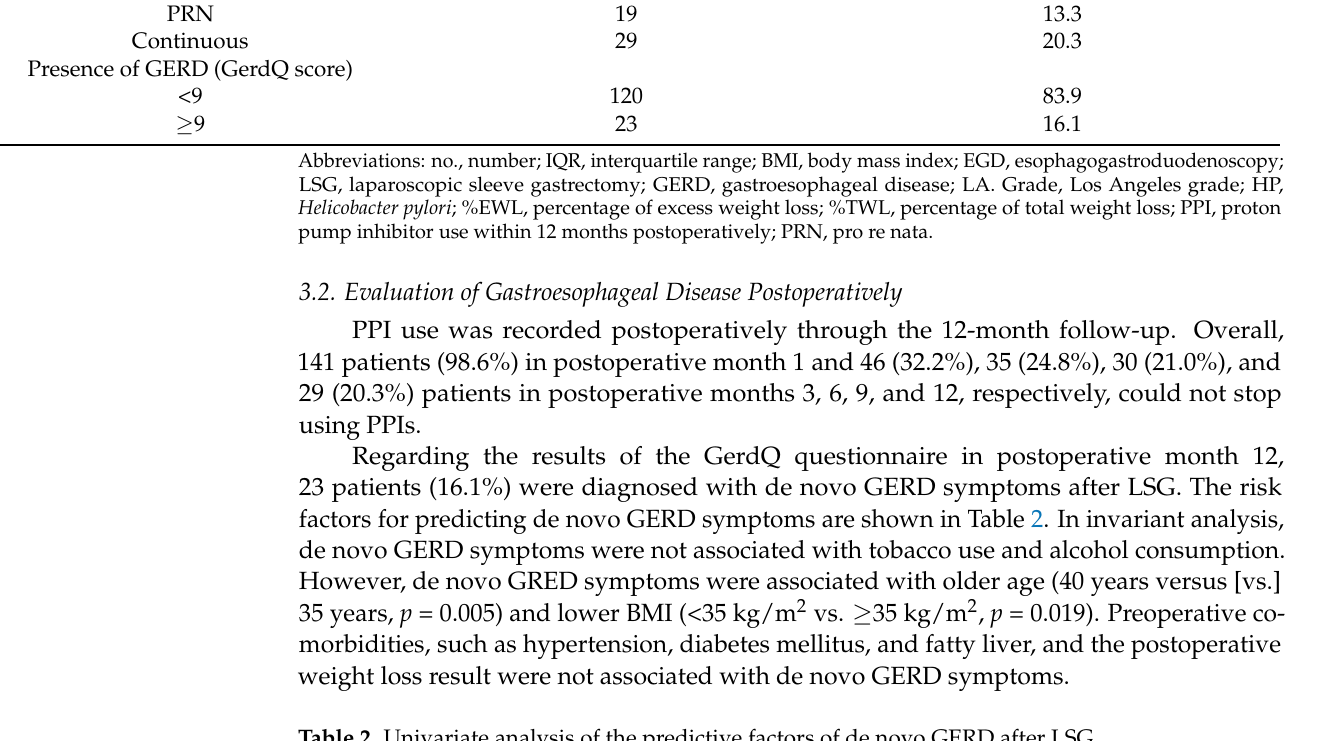
Table 2. Univariate analysis of the predictive factors of de novo GERD after